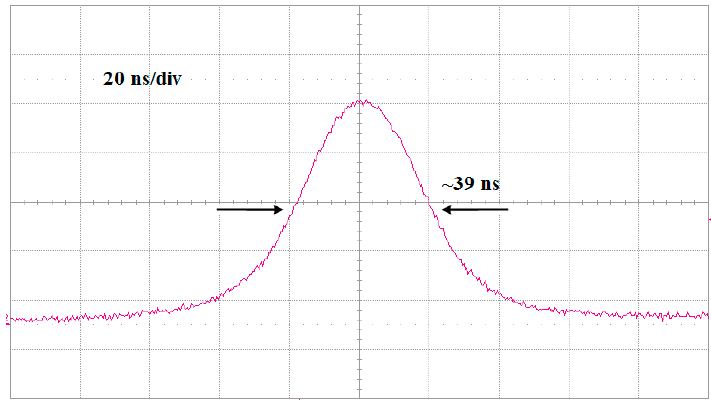
Figure 7. Single pulse trace at the maximum absorbed pump power of 11.8 W.